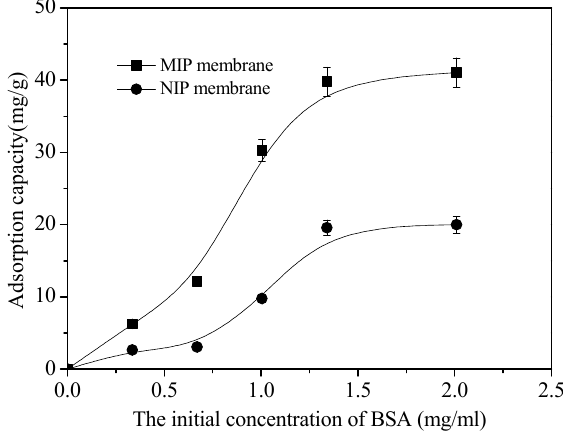
Figure 8. Curves of adsorption thermodynamics of MIP and NIP membrane.